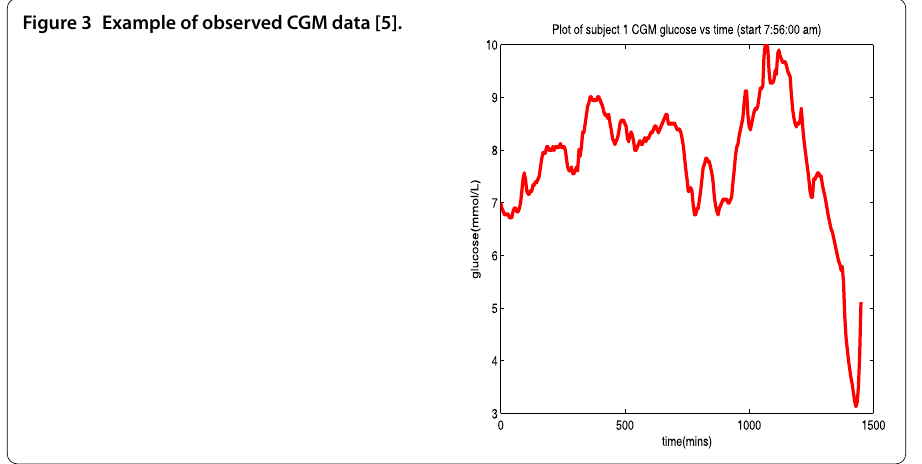
Figure 3 Example of observed CGM data